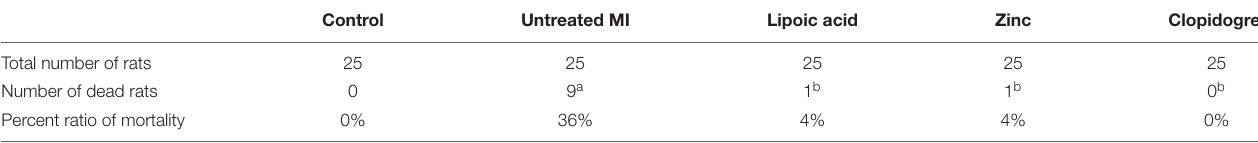
TABLE 1 | Incidence of mortality in the control, untreated MI, and pre-treated MI groups.